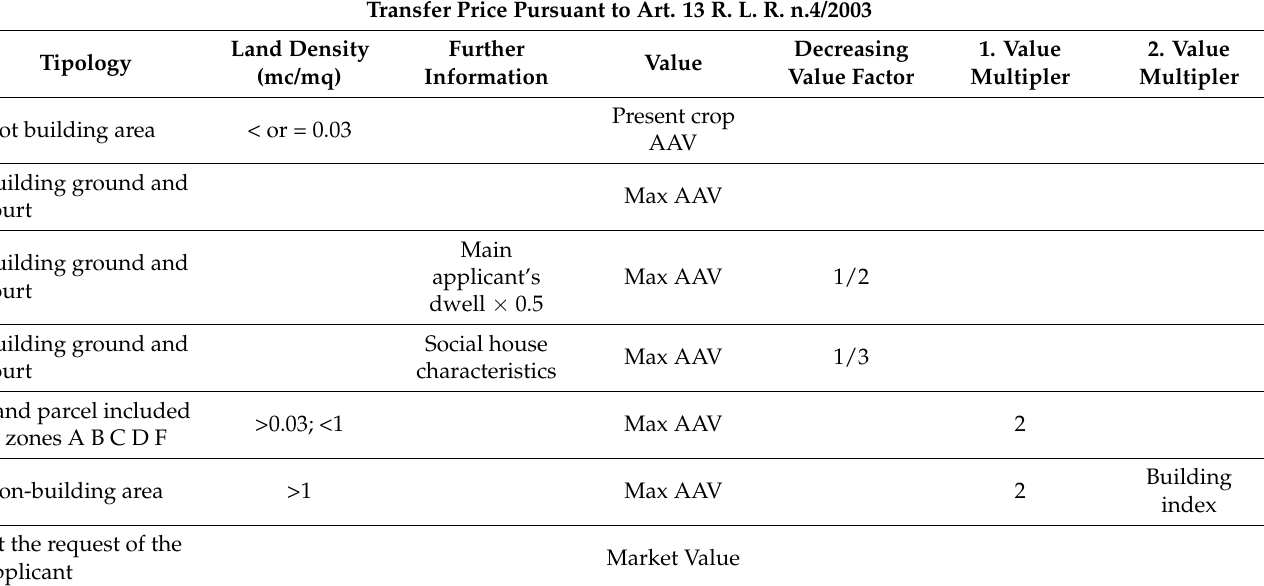
Table 1. Outline of the calculation of the sale price of the land parcels subject to the legitimation procedure.